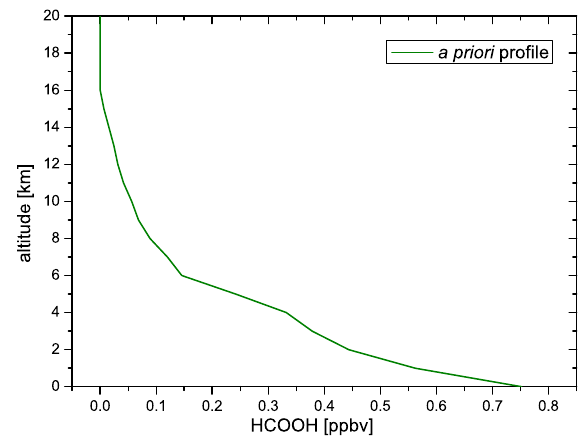
Fig. 8. HCOOH a priori profile derived from the combined aircraft and ACE measurements. See text for details.